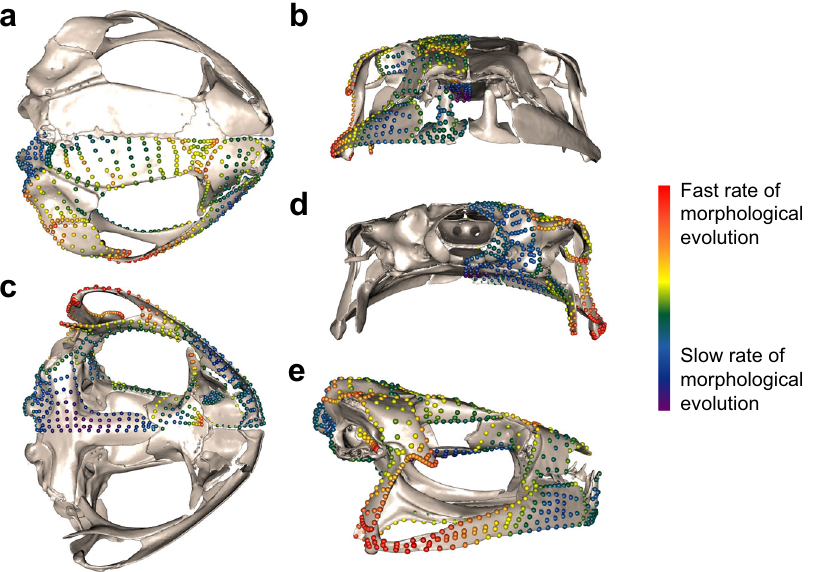
Fig. 4 Disparity across the frog cranium. Landmarks and semilandmarks shown on Adenomus kelaartii (FMNH: Amphibians and Reptiles: 1580) colour graded by magnitude of disparity (Procrustes variance), from low (purple) to high (red), in a dorsal, b anterior, c ventral, d posterior and e lateral aspect. rate (mean ρ = 0.50, p < 0.01 with error estimated, mean ρ = 0.61, p < 0.01 without error), with later-ossifying bones exhibiting greater disparity and faster rates of evolution (Fig. 6 and Supplementary Figs. 10, 11).